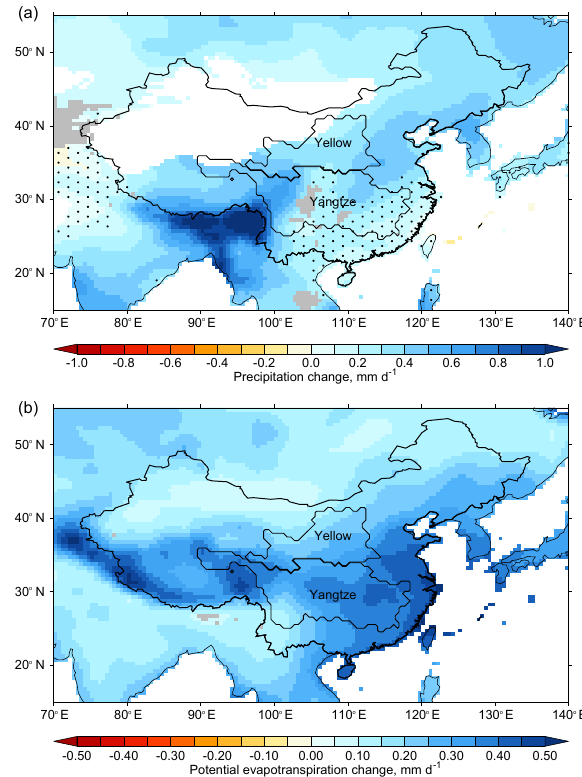
Figure 9. Multi-model mean future-minus-present changes (2080– 2099 minus 1980–1999) in P (a) and E p (b) in RCP8.5. Stippling indicates where fewer than 50% of the CMIP5 models show sig- nificant change, as determined with a t test comparing present-day and future climates. Absence of stippling indicates where more than 50% of the models show significant change and more than 80% of the significant models agree on the sign. Grey indicates where more than 50% of the models show significant change but fewer than 80% of the significant models agree on the sign. This method fol- lows Tebaldi et al. (2011). Desert regions ( < 200mmyr − 1 ), as de- termined from CRU climatology (1961–1990), are masked in white for P